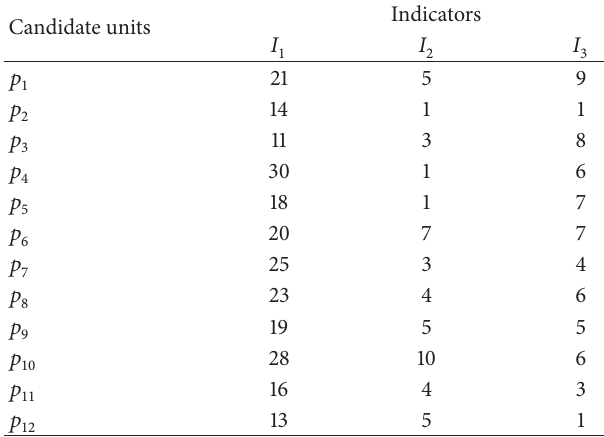
Table 2: Initial information of individual indicators 𝐼 1 , 𝐼 2 , and 𝐼 3 of candidate